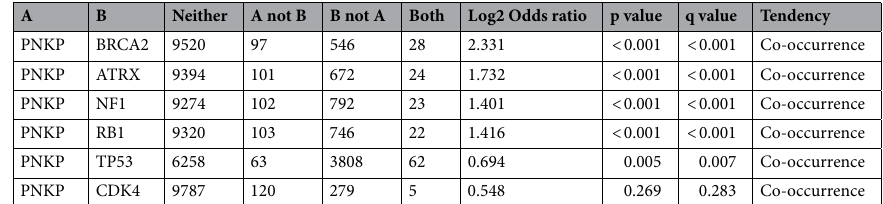
Table 1. Mutual exclusivity analysis of PNKP and candidate mutations that were found in the patient’s tumor sample. Mutual exclusivity between PNKP and candidate mutations in TCGA PanCancer Atlas studies in cBioPortal. Neither: Numbers of samples with alterations in neither A or B. Only A/Only B: Numbers of samples with alterations in only gene A/B. Both A + B: Numbers of samples with alterations in both gene A and B. Log2 odds ratio: Quantifies how strongly the presence or absence of alterations in A are associated with the presence or absence of alterations in B in the selected samples. OR = (Neither * Both)/(A Not B * B Not A). Log2 odds ratio > 0: Tendency towards co-occurrence. Log2 odds ratio < = 0: Tendency towards mutual exclusivity. p-value: derived from one-side Fisher Exact Test. q-Value: derived from Benjamini–Hochberg FDR correction